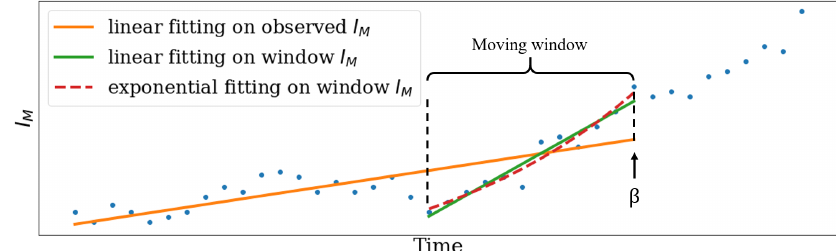
Figure 3. Detection of degradation intensification ( β )